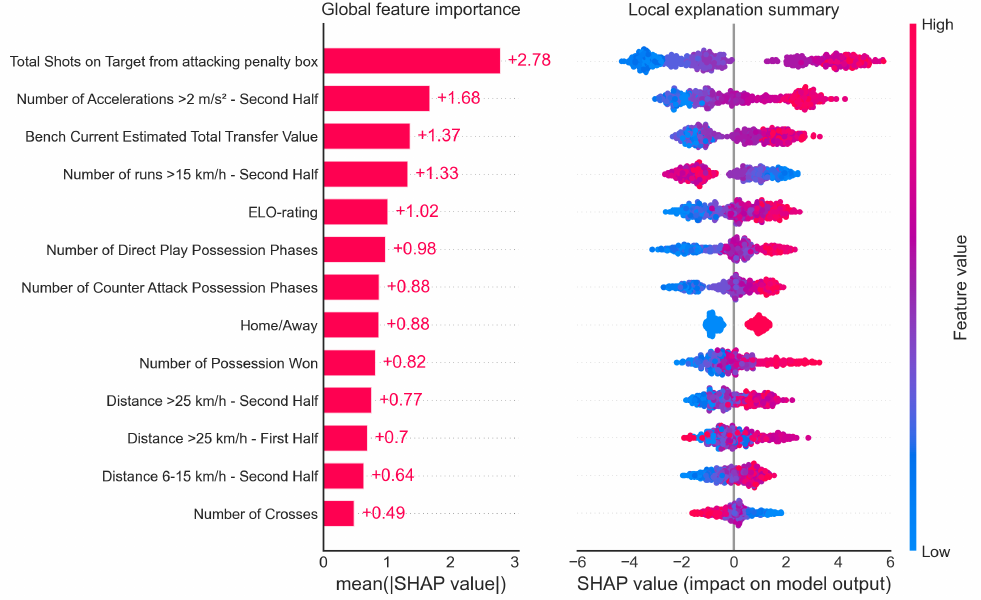
Figure 3. Feature importance based on SHAP-values. On the left side, the mean absolute SHAP- values are depicted, to illustrate global feature importance. On the right side, the local explanation summary shows the direction of the relationship between a variable and game outcome. Posi- tive SHAP-values are indicative of winning, while negative SHAP-values are indicative of losing. As demonstrated by the colorbar, higher values are shown in red, while lower values are shown in blue. As an example, this shows that positive differences between total shots on target from the attacking penalty box between teams are associated with winning, while negative differences are associated with